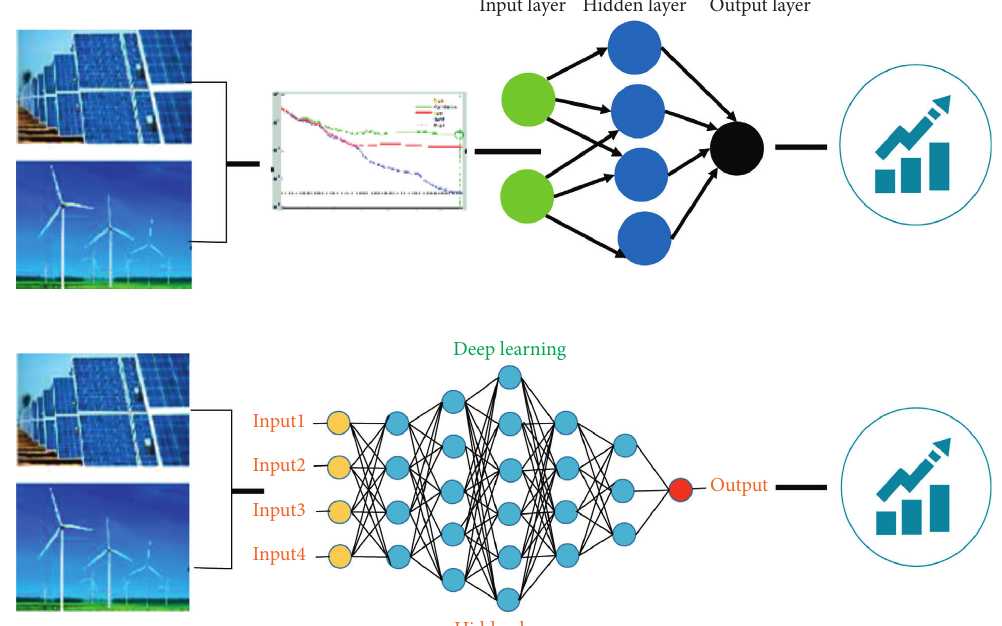
Figure 4: Difference of simple neural network and deep learning in feature combination techniques.